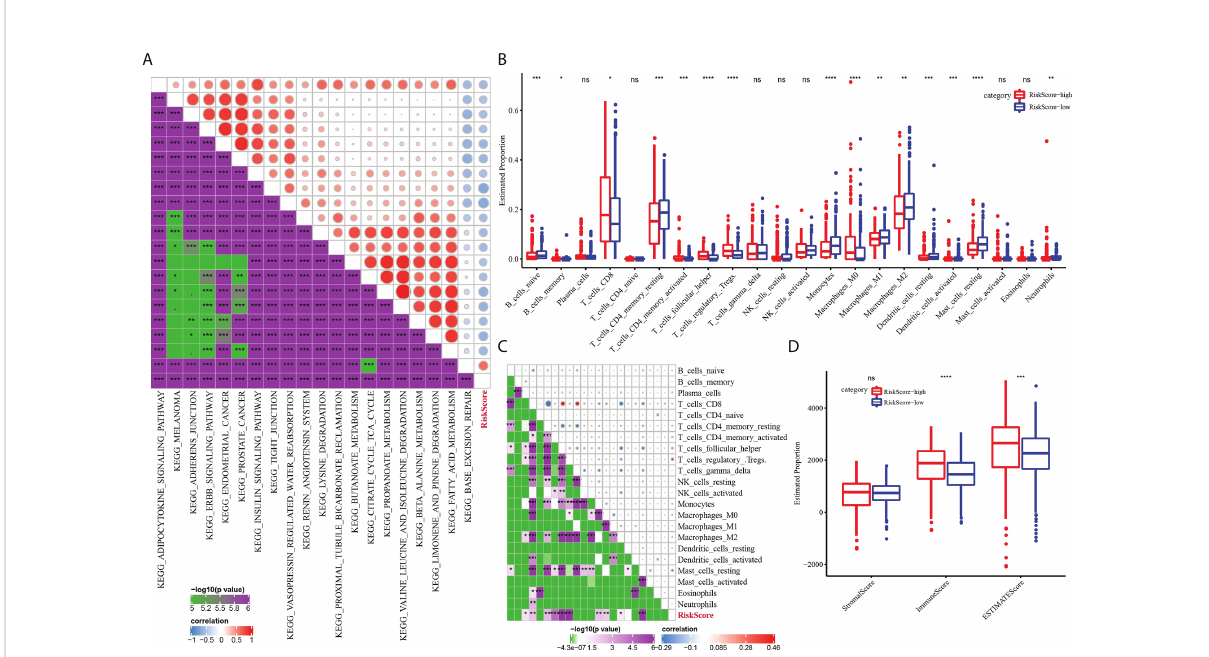
FIGURE 8 The immune characteristics of ccRCC were characterized by the risk model. (A) The relationship between risk score and KEGG signal pathway. (B) Analysis for the difference in the proportion of 22 kinds of immune cells between the high-risk subgroup and low-risk subgroup. (C) Pearson correlation between risk score and 22 kinds of immune cells. (D) The difference of three TME-related scores between the high-risk subgroup and low-risk subgroup. * P < 0.05, ** P < 0.01, *** P < 0.001, **** P < 0.0001. ns, not signi fi